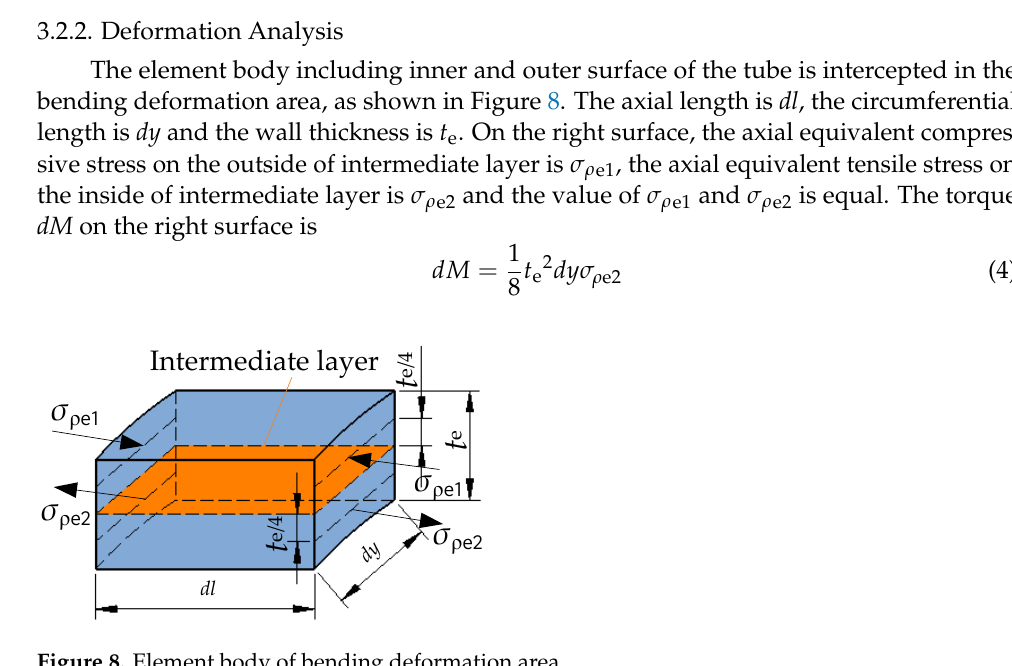
After the tube end is deformed in the bending stage, the axial elongation of the inside metal of the intermediate layer is greater than that of the outside, so that the end warped upward to form end warping area. As shown in Figure 9, there is shear deformation in the end warping area, which results in the shear stress τ n ρ on the lower surface of unit body pointing from left to right, and the shear stress τ ρ n on the right surface of unit body pointing from top to bottom. After the tube end deformed in the warping stage, the intermediate layer radius of the thick and thin wall side is increased to R m3 and R n3 , respectively, the corresponding wall thickness is decreased to t m3 and t n3 ,